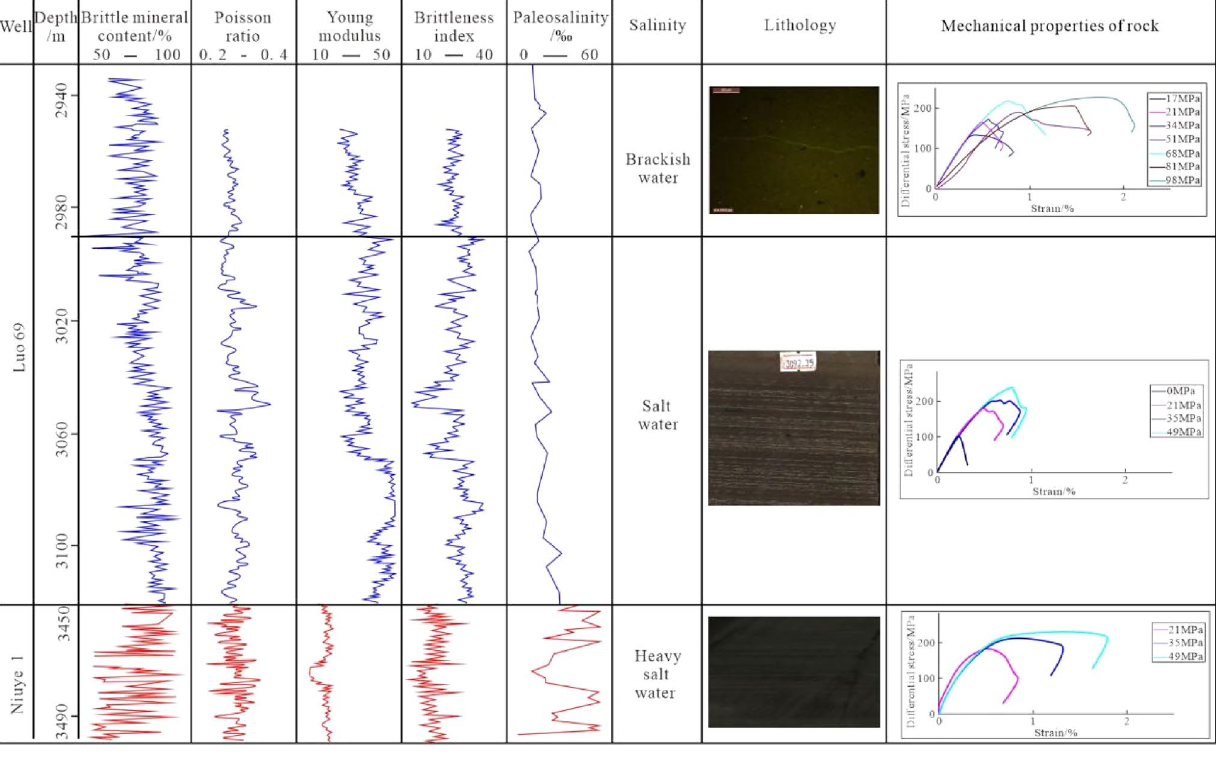
Fig. 11 Diagram of compressibility relationship between salinization stage and mud